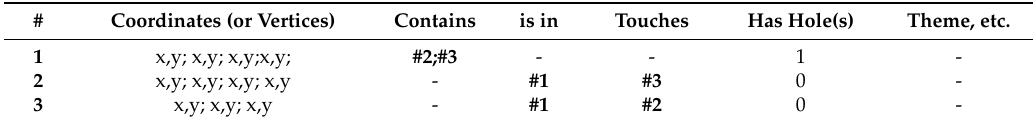
Table 1. Encoding the geometry and the topology of a set of land